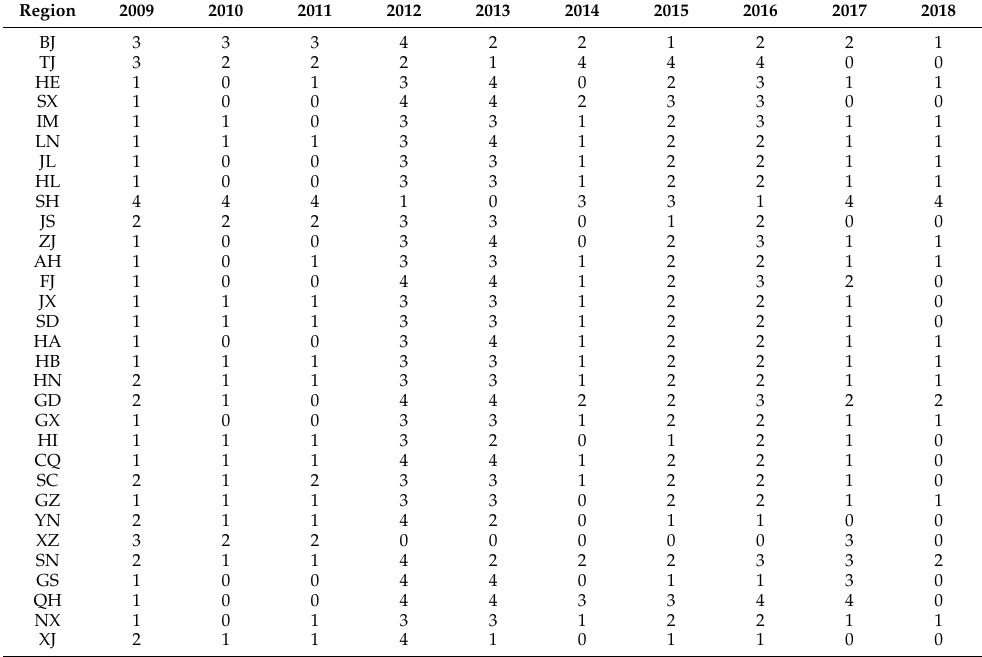
Table 8. Spatial and temporal differentiation of the level of ecological development in the forestry